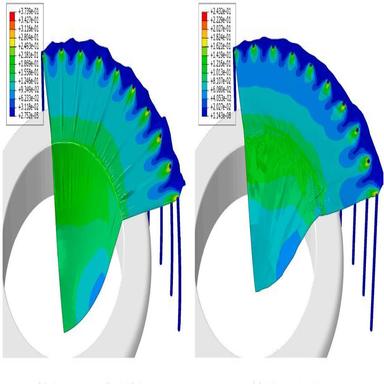
Logarithmic membrane principal strain in the mesh at maximum loading (a) and after unloading (b), showing the residual strain and remaining bulge. Strain magnitudes are within the experimental domain of uni and biaxial tests, except in the close vicinity of fixation points.